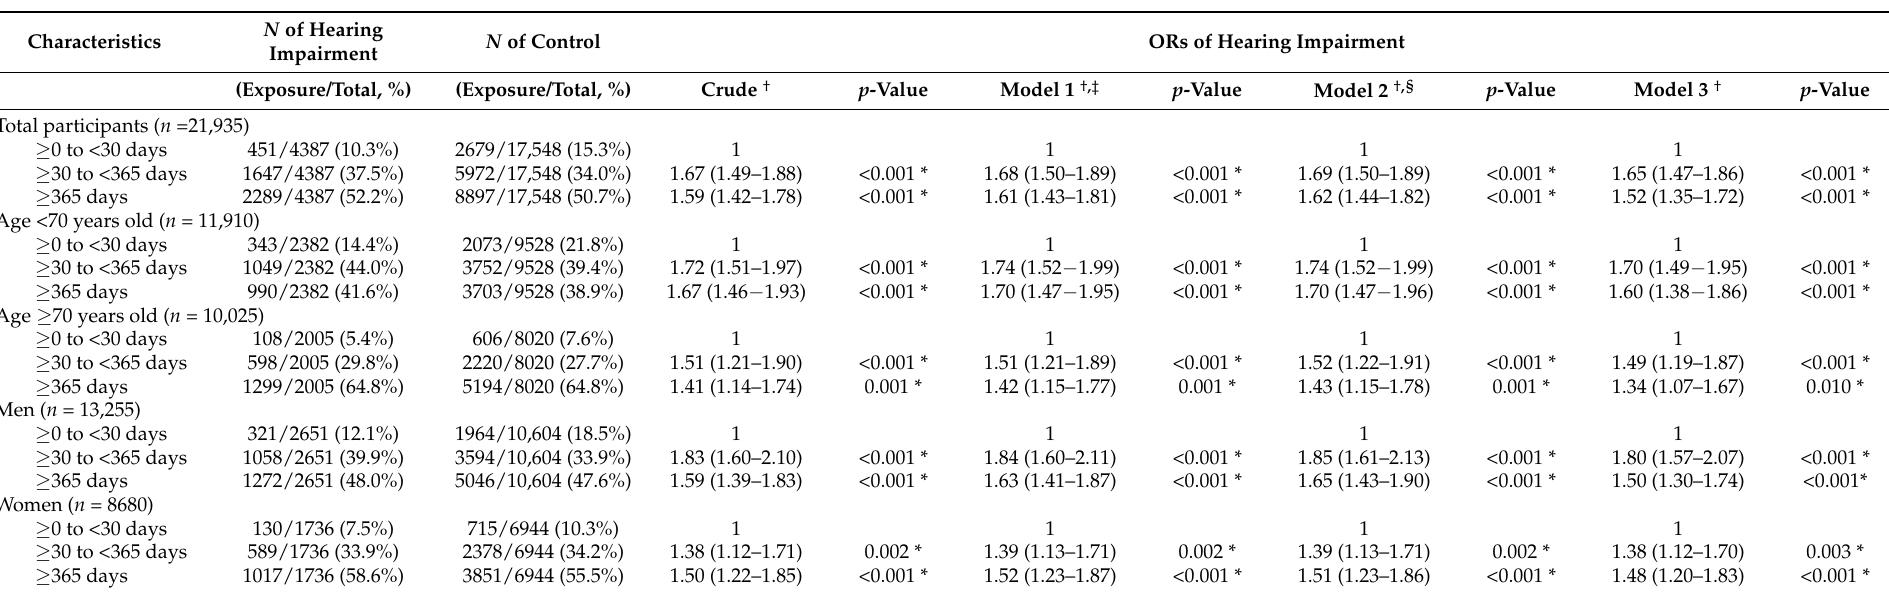
Table 2. Crude and adjusted odds ratios (95% confidence interval) of prescription dates of proton pump inhibitor for hearing impairment with stratified subgroup according to age and sex.